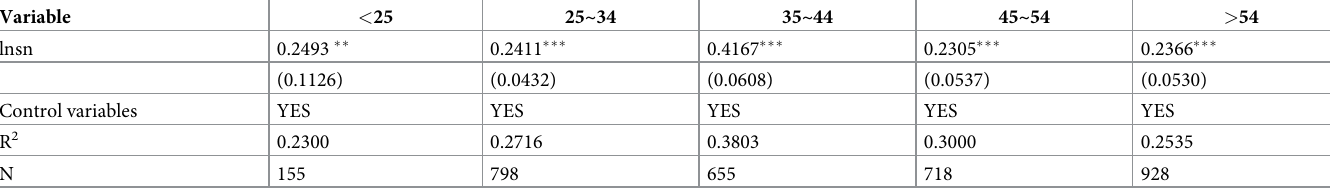
Table 7. Estimated results of the household life